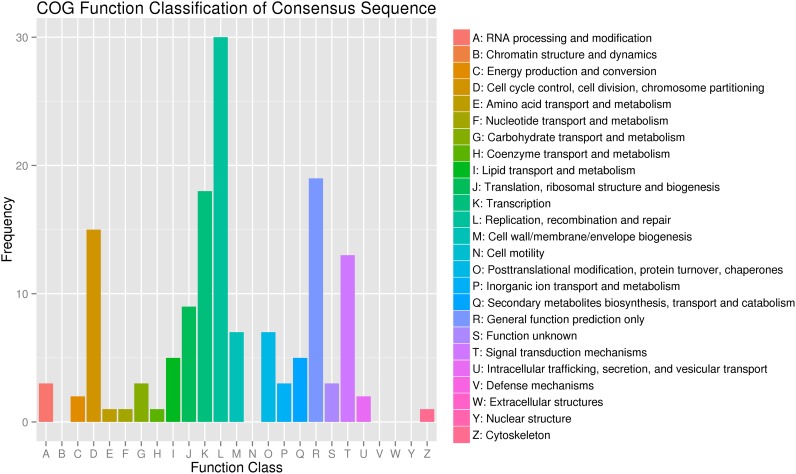
Functional classification of the new genes using COG.